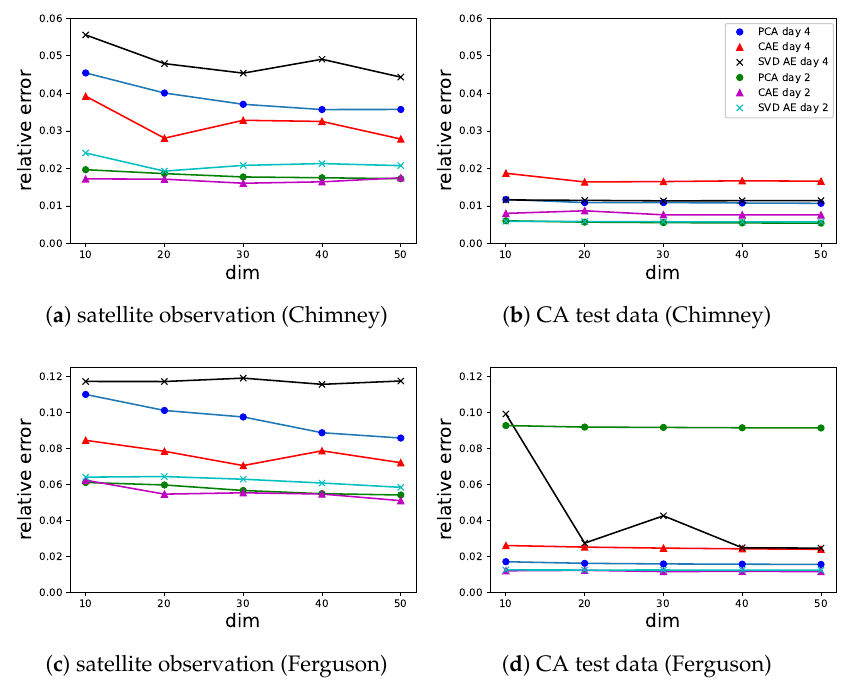
Figure 4. Relative reconstruction error of satellite observations and CA simulations in the test dataset against the dimension of the latent